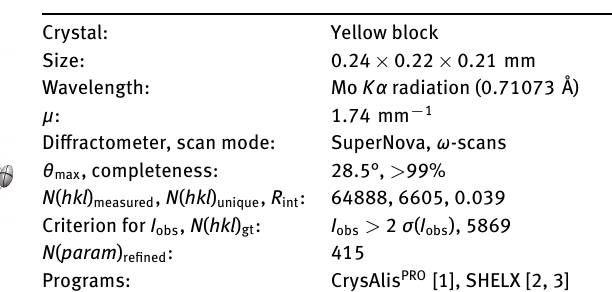
Table 1: Data collection and handling.